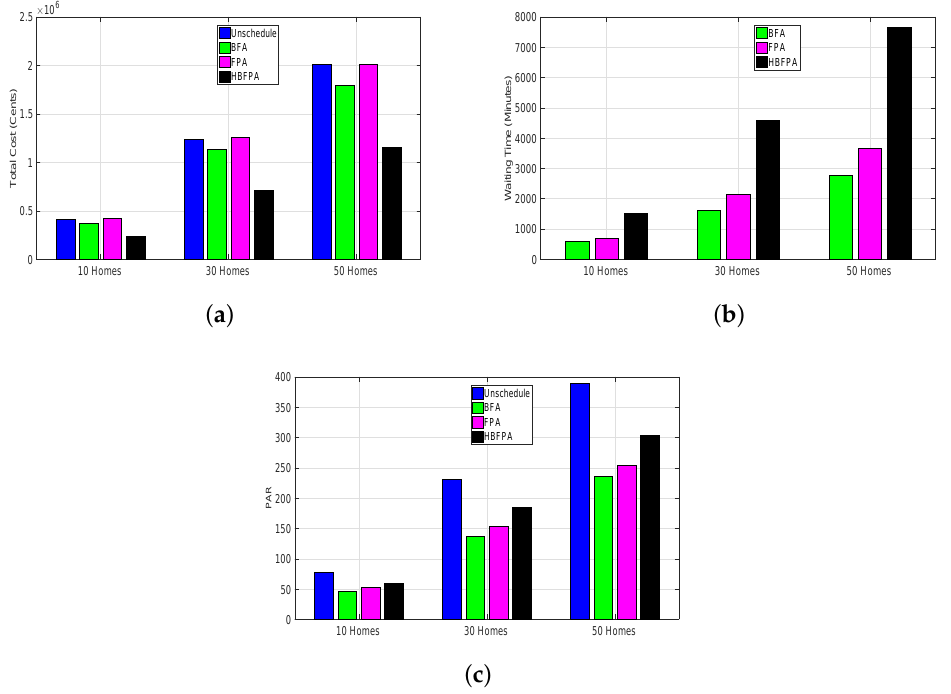
Figure 9. Electricity cost, waiting time and peak to average ratio for multiple homes: (10, 30 and 50) using critical peak pricing. ( a ) Electricity cost using operational time interval of 1 min; ( b ) Waiting time using operational time interval of 1 min; ( c ) Peak to average ratio using operational time interval of 1 min. Table 12. Electricity cost for 24 h (for multiple homes).